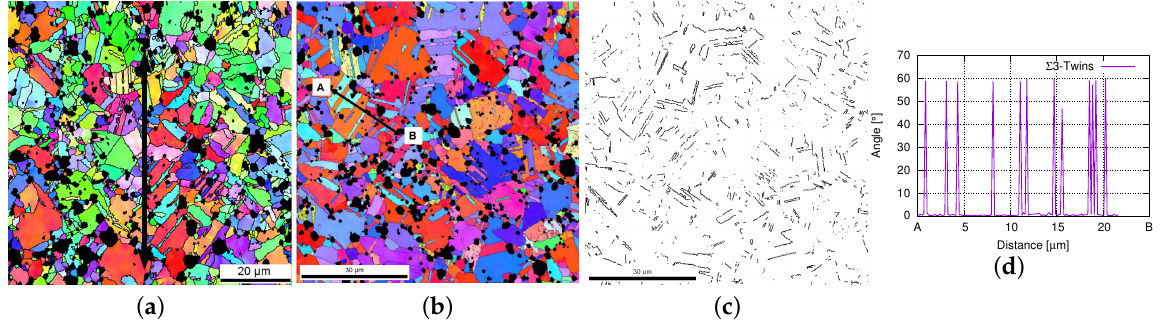
Figure 2. PM12-3 composite (Table 1) from EBSD measurements: ( a ) in the longitudinal direction, where the arrow presents the extrusion direction [26]; ( b ) in the transverse direction [26]; ( c ) the Σ 3-twin boundaries for the microstructure given in ( b ); ( d ) the measured Σ 3-twin angles along the line AB marked in ( b